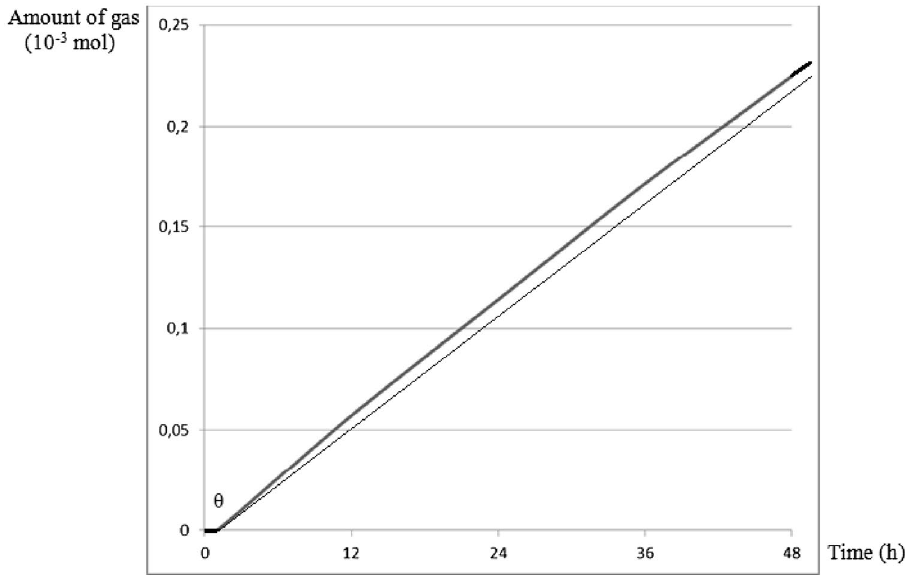
Fig. 4 Graph of nitrogen per- meation results